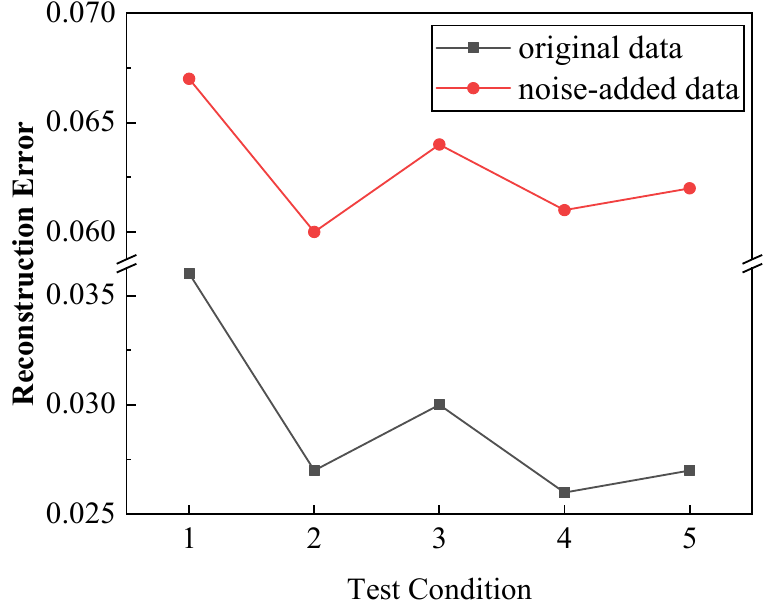
Figure 7. Optimized effects of core tensor dimension.